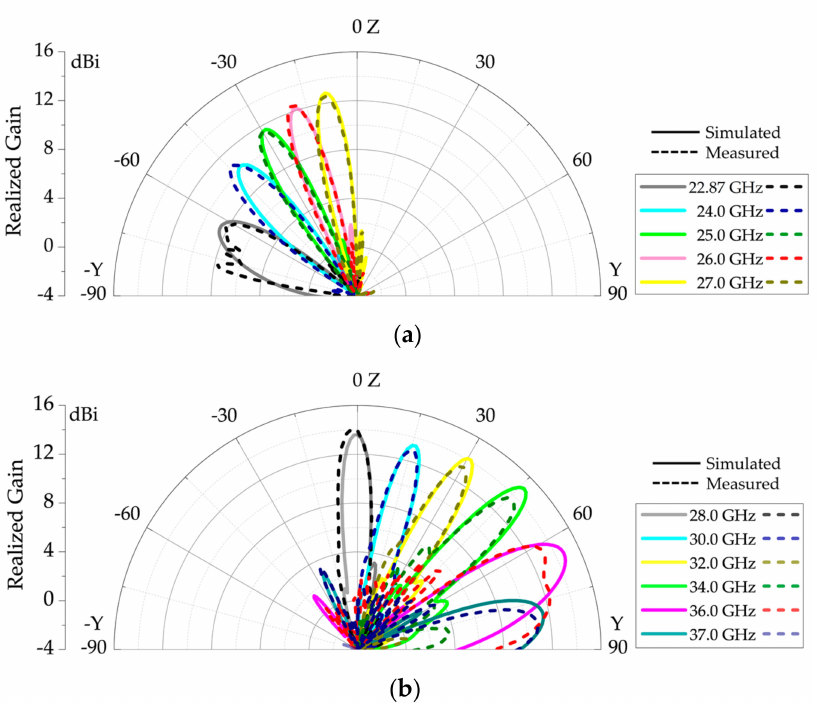
Figure 11. Scanning range of the proposed 1-D periodic modified BAA-LWA with bowtie and semi-circular unit-cell ( a ) backward quadrant and (b ) forward quadrant.